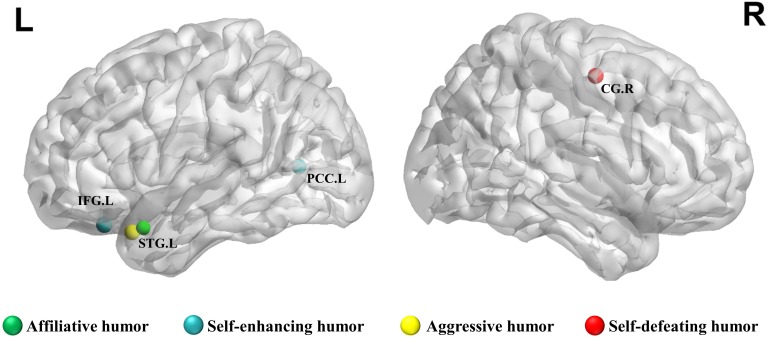
The spatial distribution of cortical regions showing a significant relationship between nodal efficiency and humor styles score (p < 0.005). R, right hemisphere; L, left hemisphere; CG, cingulate gyrus; IFG, inferior frontal gyrus; PCC, posterior cingulate; STG, superior temporal gyrus.